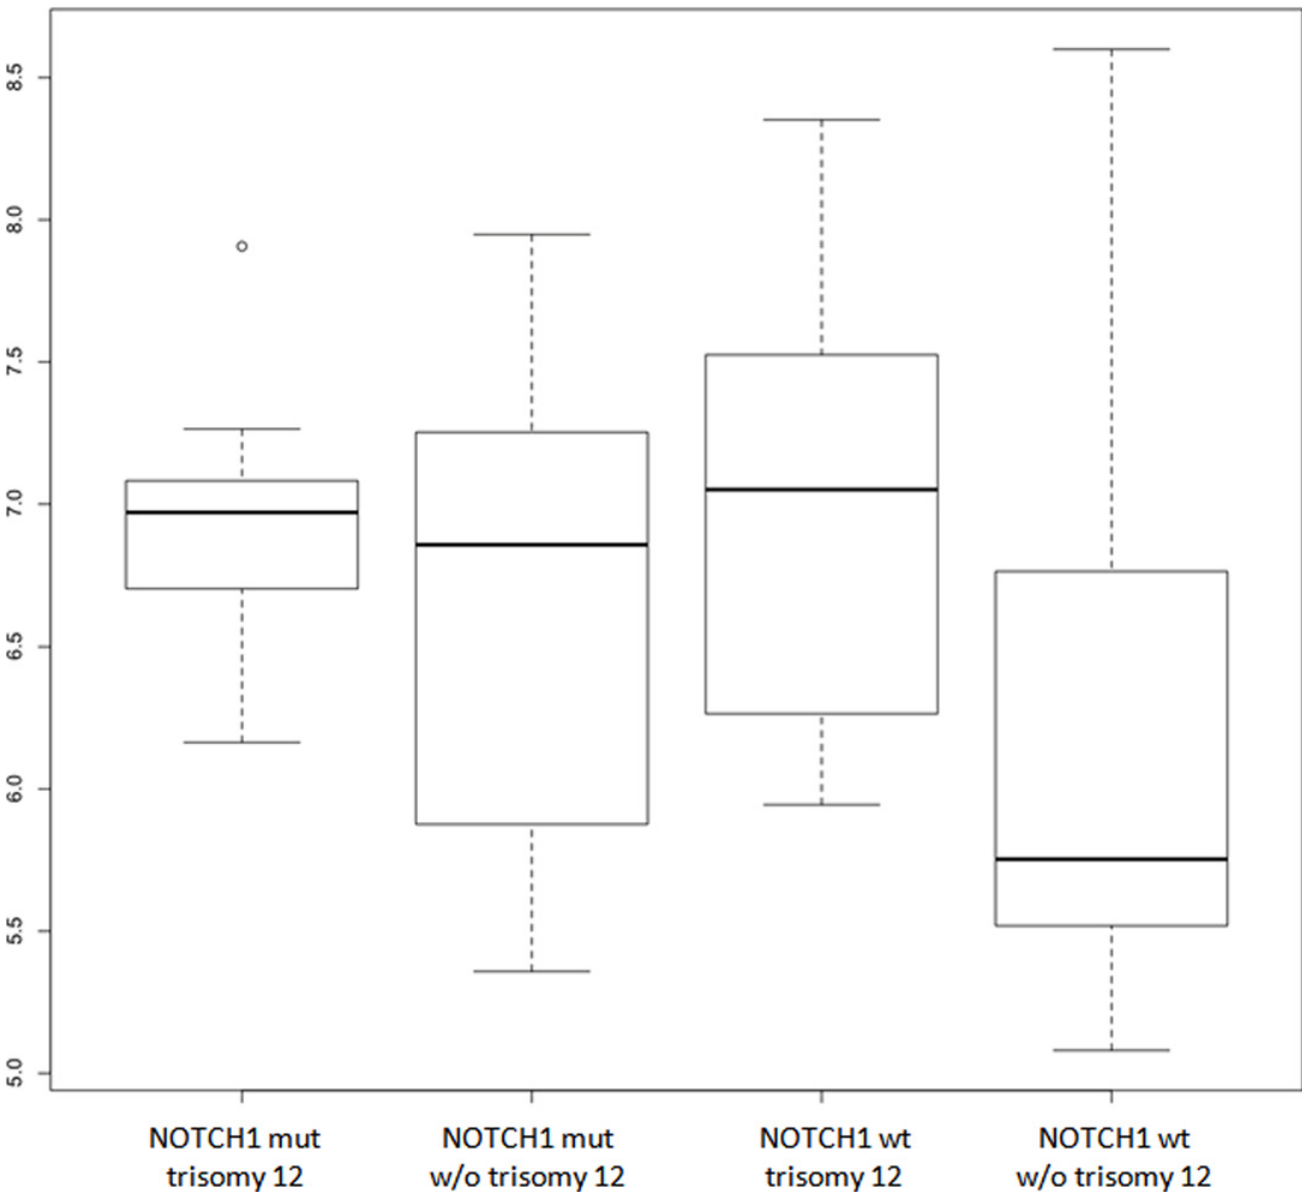
Fig 3. Boxplot of IGF1R expression in patients stratified according to trisomy 12 and NOTCH1 mutation (mut: mutation; wt: wild-type; w/o: without). IGF1R was significant higher among the NOTCH1 mut/trisomy12, NOTCH1 mut/NOtrisomy12 and NOTCH1,wd/trisomy12 compared to other patients (p = 0.0035, p = 0.0031 and p = 0.0002